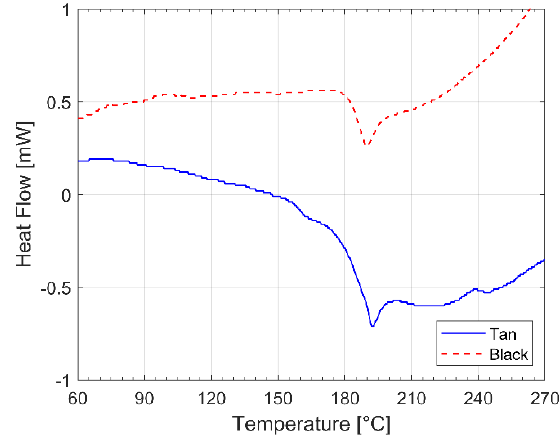
Figure 4. Differential scanning calorimetry for ULTEM TM 9085 tan and black.